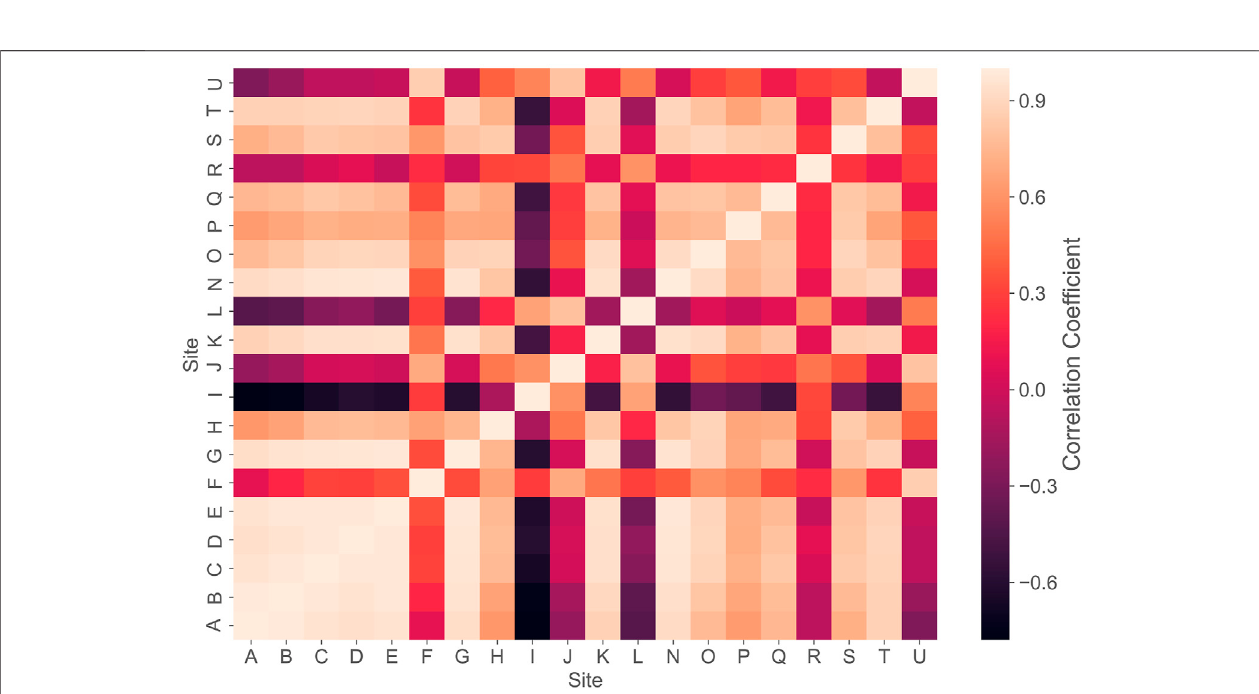
FIGURE 3 | Correlation heatmap of all